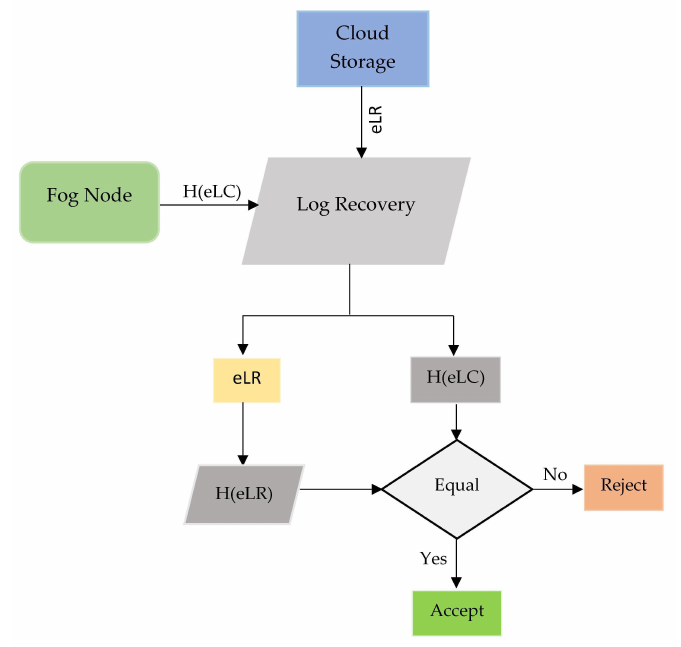
Figure 30. Log verification